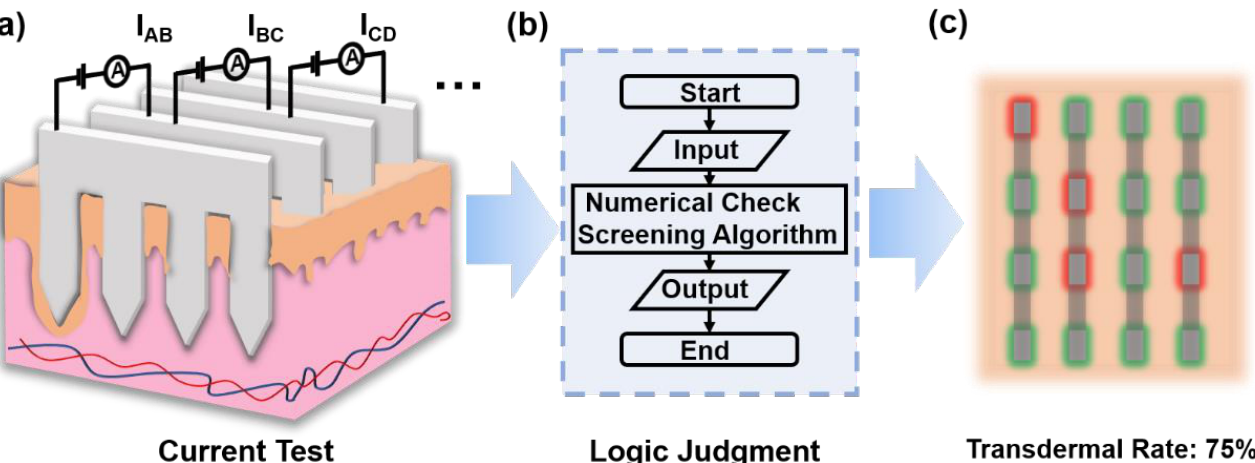
Figure 1. Schematic illustration of the impedance measurements-based numerical check screening algorithm. ( a ) The metallic microneedle arrays are inserted into the skin and the current between each row is measured respectively. ( b ) A logic judgment process is run with the measured current to calculate the transdermal rate. ( c ) The transdermal results are shown in two different colors. Red stands for the site where the microneedle is not penetrated, while green stands for the penetrated site by the microneedle.